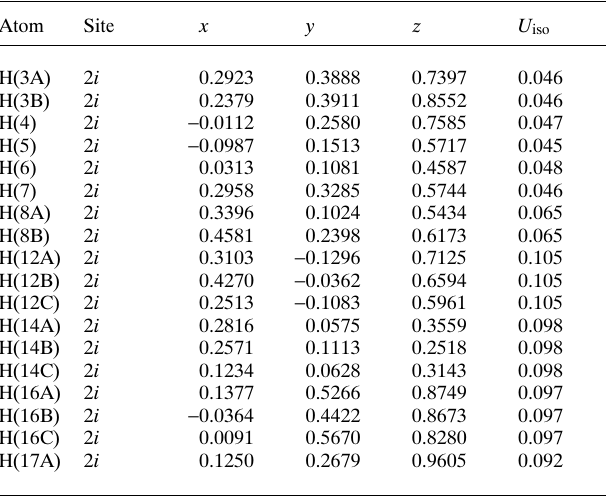
Table 2. Atomic coordinates and displacement parameters (in Å 2 ) .